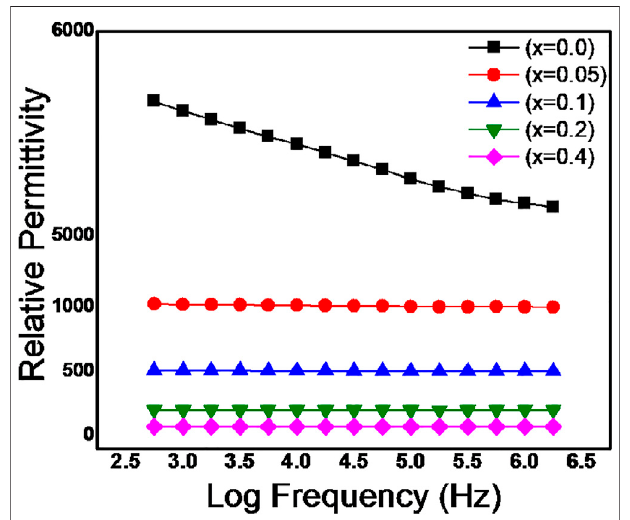
FIGURE 4 | Variation of Relative Permittivity of BaZr 0.2 [Ti (1-x) Mg x/3 Ta 2x/3 ] 0.8 O 3 for 0.0 < x < 0.4 with frequency.